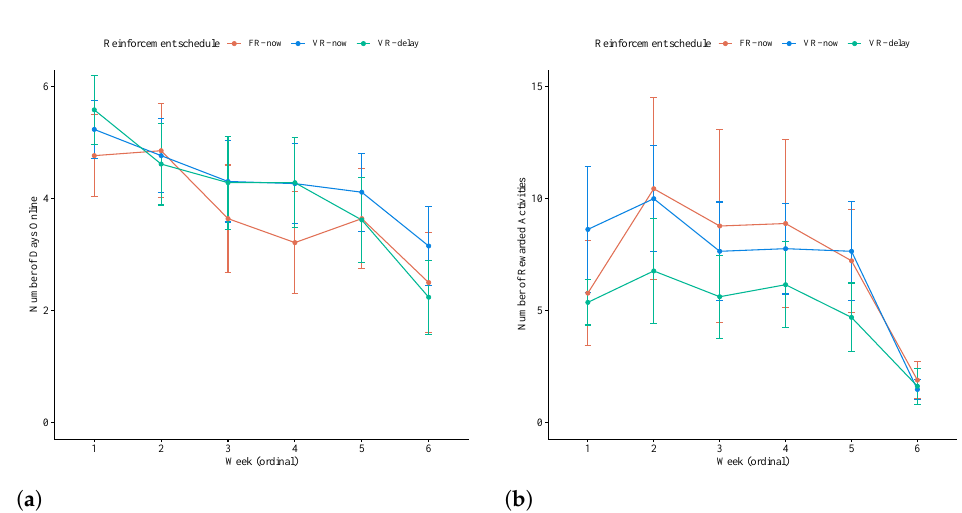
Figure 5. Mean plots per reinforcement schedule of: ( a ) the number of days participants visited the web app (all participants, N = 61), and ( b ) the number of activities participants registered (active participants, N = 39).